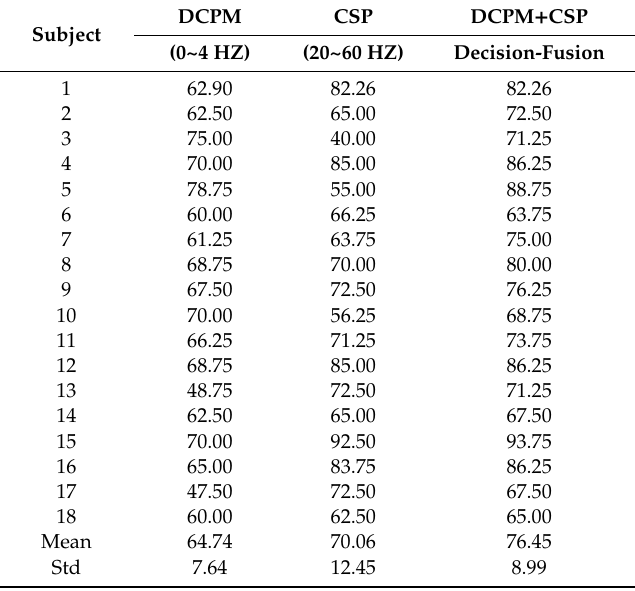
Table 1. Classification accuracy comparisons.